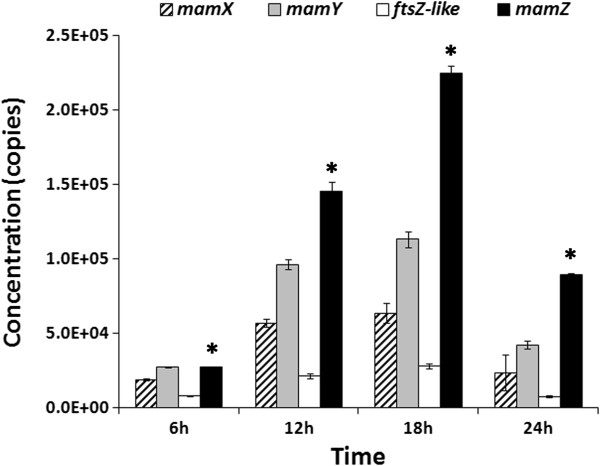
Absolute qPCR results for transcription levels of the four genes (mamY , mamX, mamZ, ftsZ-like) in the mamXY operon in WT. Each of the genes had a high transcription level from 12 to 18 hr, corresponding to the log phase of growth. The transcription level of mamZ was much higher than those of the other three genes at all four sampling times. *, 1/3 of original transcription level of mamZ in the figure was showed for better display of the other gene transcriptions.